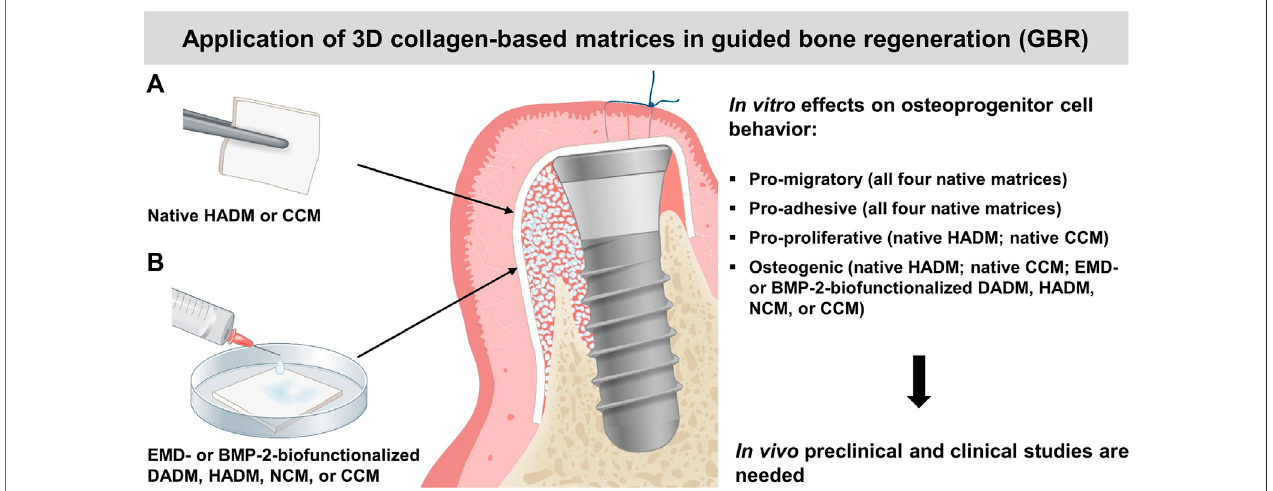
FIGURE8| Summaryofthe invitro resultsandsuggestedclinicalapplicationoftheinvestigated3Dcollagen-basedmatricesinguidedboneregeneration(GBR).A schematic presentation of GBR with the use of autogenous bone or bone substitute material (white granules) for bone augmentation and a collagen matrix (pointed by arrows) as a barrier. The selective ingrowth of bone-forming cells into a bone defect site may be improved by the osteoinductive properties of the native HADM or CCM (A) , or the EMD- or BMP-2-biofunctionalized DADM, HADM, NCM or CCM (B) . The clinical application ofthe matrices in GBR is supported by their positive effects on the migratory, adhesive, proliferative, and differentiation properties of osteoprogenitor cells observed in vitro . The suggested application needs to be proved in future in vivo pre-clinical and clinical studies.